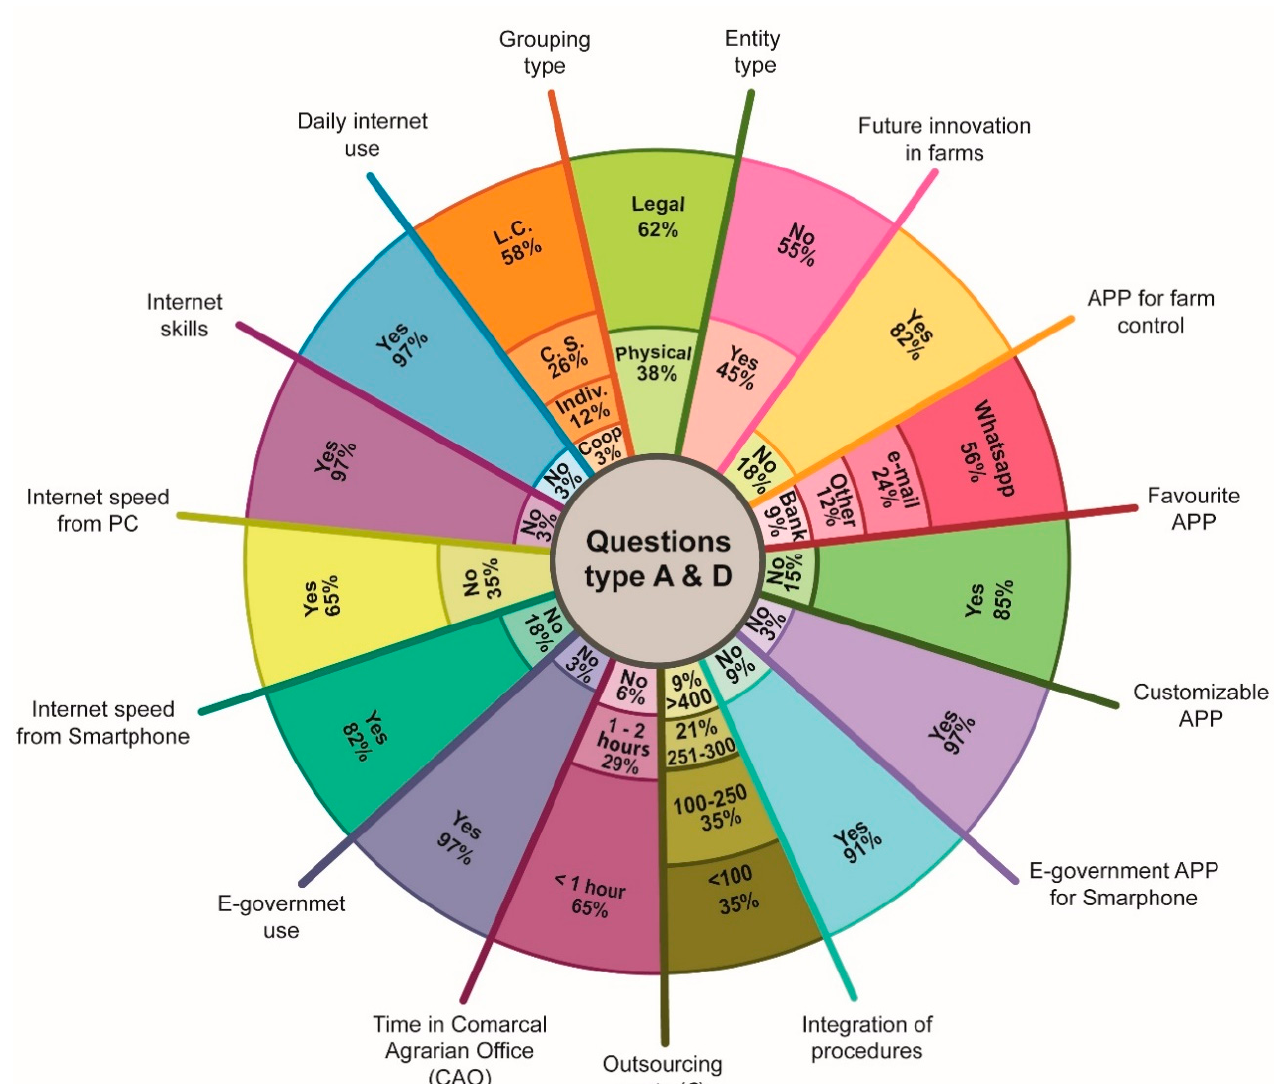
Figure 6. Personal Questions and Aptitudes towards ICT. Percentage of Answers.